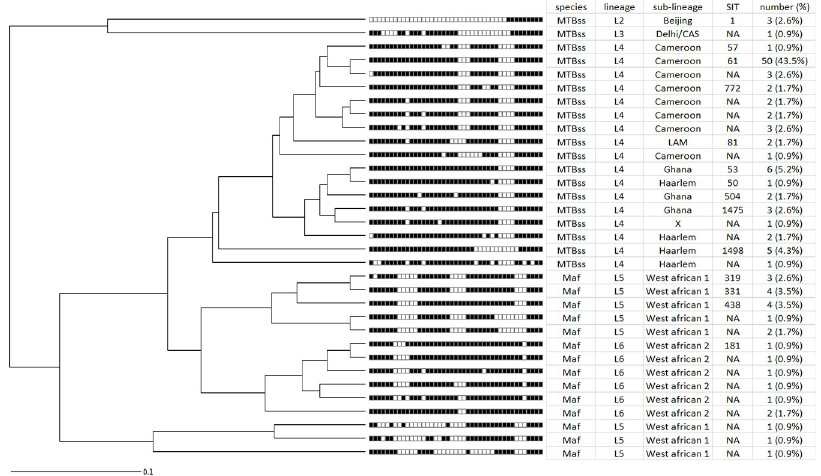
Fig 2. Relationship of identified 33 spoligotype profiles. Tree was plotted using the MIRU-VNTR plus web application available at https://www.miru-vntrplus.org/.